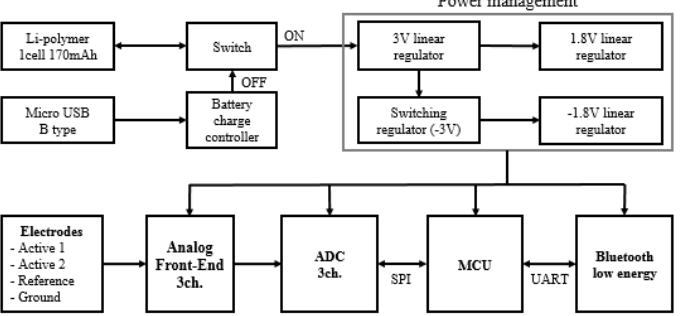
Figure 1. Circuit diagram of the wearable electroencephalogram (EEG) and electrocardiogram (ECG) recording system.